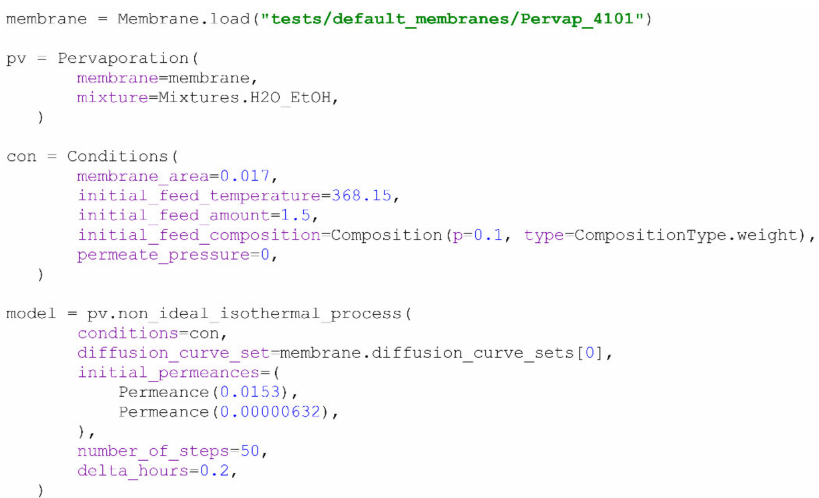
Scheme 12. Modelling of the non-ideal isothermal process described in [45] using the membrane performance data provided in [24].